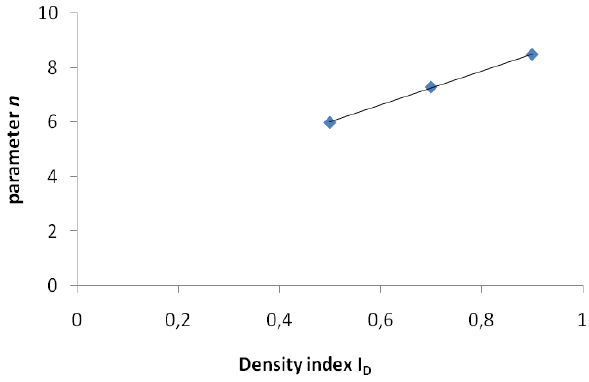
Figure 10: Evolution of the parameter ( n ) as a function of the density index I D.